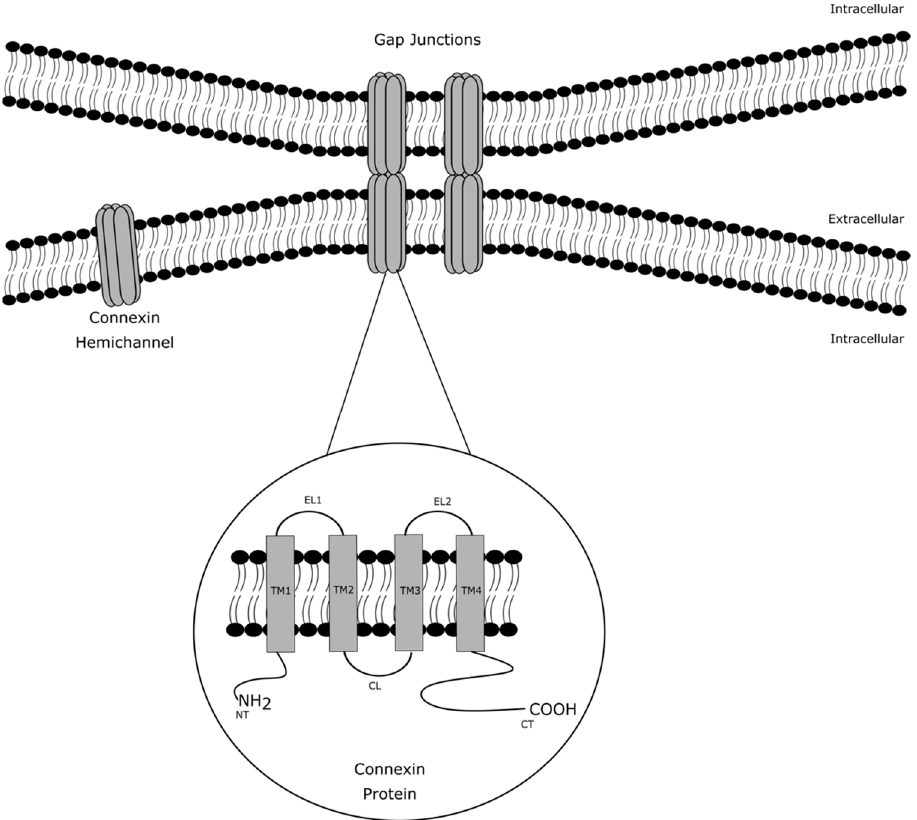
Figure 1. Architecture of gap junction, connexin hemichannels and connexin proteins. Gap junctions arise from the interaction of two connexin hemichannels of adjacent cells. A connexin hemichannel is built up by six connexin proteins. A connexin protein consists of four transmembrane domains (TM1-4), two extracellular loops (EL1-2), one cytosolic loop (CL), one cytosolic carboxyterminal tail (CT) and one cytosolic amino tail (NT). Table 1. Mechanisms underlying connexin hemichannel activation in